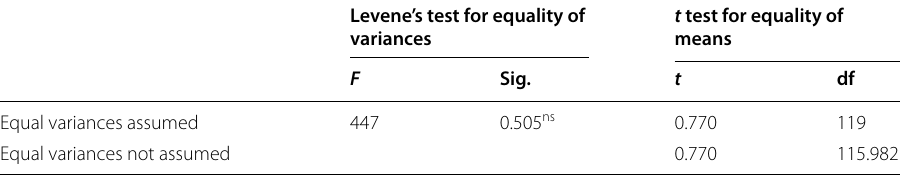
ns non‑significance level is 0.05